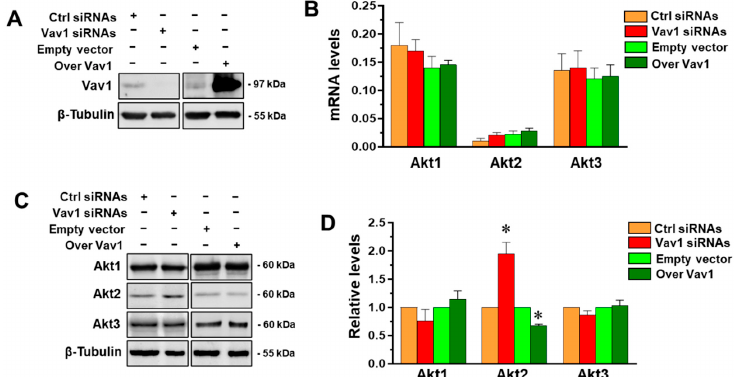
Figure 1. Correlation between Vav1 and Akt isoforms in MDA-MB-231 cells. ( A ) Representative immunochemical analysis of lysates from MDA-MB-231 cells transfected with siRNAs specific for Vav1 (Vav1 siRNAs) or with a construct expressing Vav1 (Over Vav1). Scramble siRNAs (Ctrl siRNAs) and an empty vector were used as controls. β -Tubulin was blotted as an internal control of loaded proteins. ( B ) qRT-PCR analysis of mRNA (2 − ∆ Ct method) and ( C ) representative Western blot of Akt1, Akt2 and Akt3 in MDA-MB-231 cells cultured under the above reported experimental conditions. ( D ) Levels of Akt isoforms as deduced from the chemiluminescence signal normalized with β -Tubulin. Asterisks indicate statistically significant differences with respect to corresponding controls taken as 1. All the data are the means of 3 separate experiments ± SD. * p < 0.05.